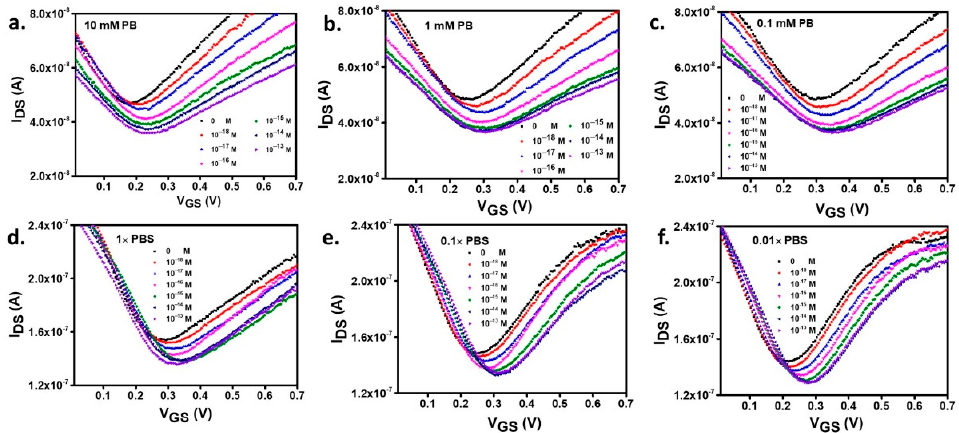
Figure 4. I DS V GS curves of DNA hybridization detection using background solution of PB of ( a ) 10 mM, ( b ) 1 mM and ( c ) 0.1 mM and PBS ( d ) 1×, ( e ) 0.1×, and ( f ) 0.01×.